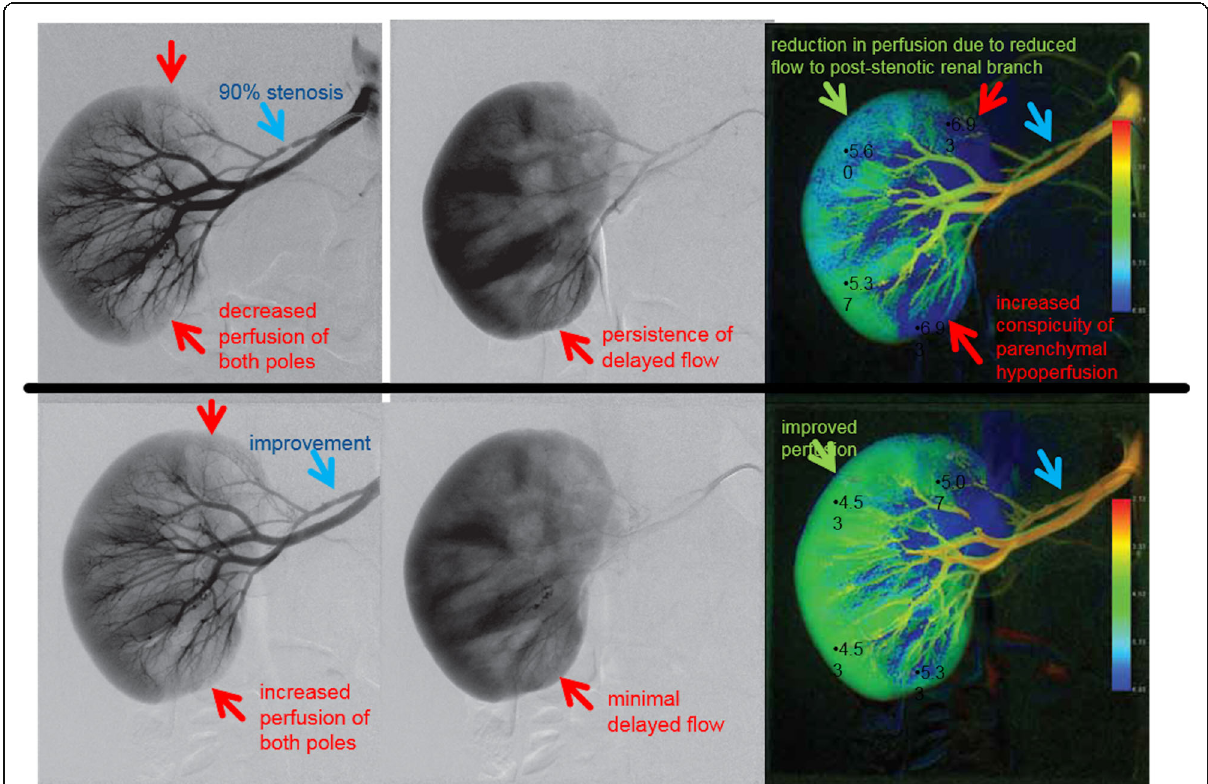
Fig. 4 Angiographic perfusion imaging. Images of pre and post angioplasty angiography with post processing using Syngo I flow (Siemens AX) non parametric imaging data: time to peak opacification demonstrating using color coding and time points demonstrating improved time to renal perfusion post right renal accessory stenosis